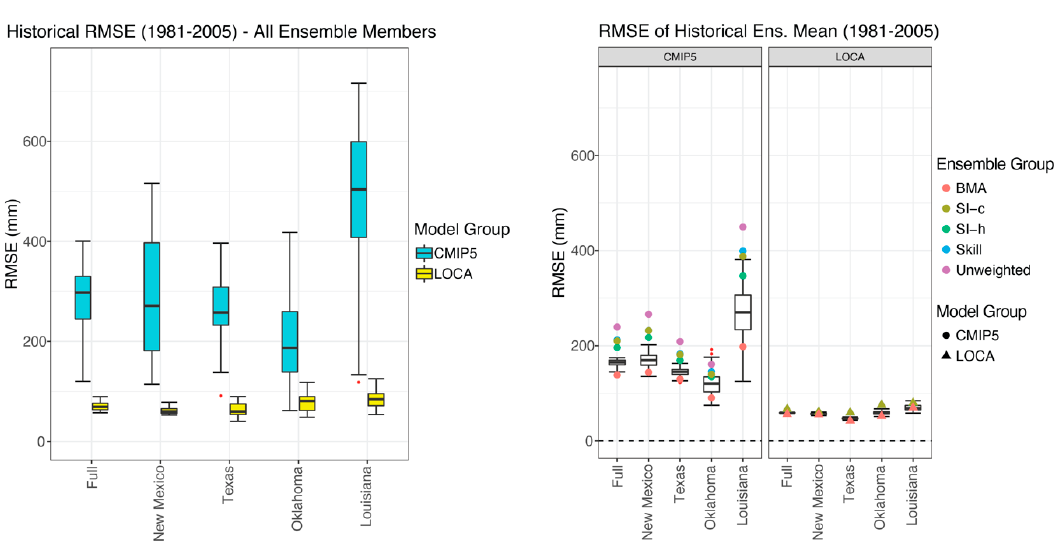
Figure 6. Left—RMSE of CMIP5 and LOCA ensembles. Right—RMSE of weighted ensemble means with boxplot of BMA simulated RMSE of ensemble means.